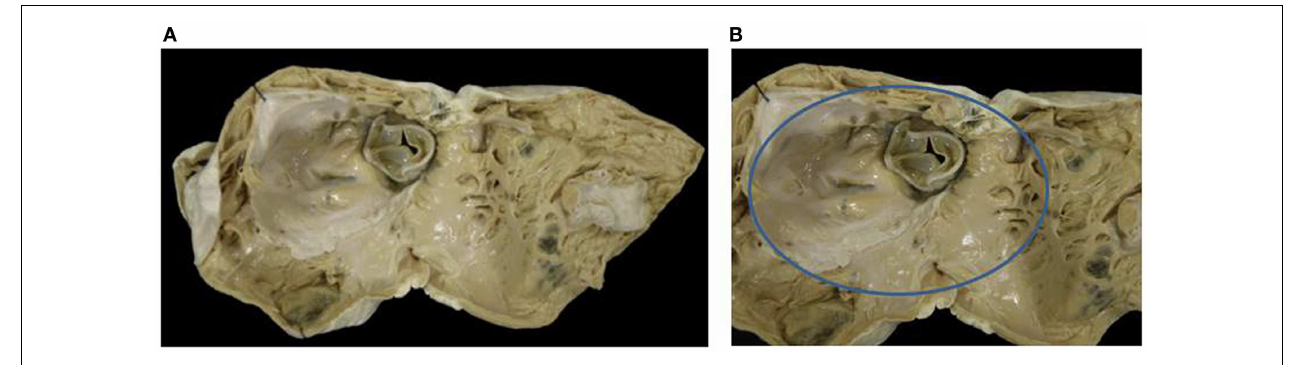
the right ventricle. In this patient, heart transplantation was performed because the dilated right ventricle was unable to sustain the pulmonary circulation. (B) Close up of the same specimen showing the atrialized